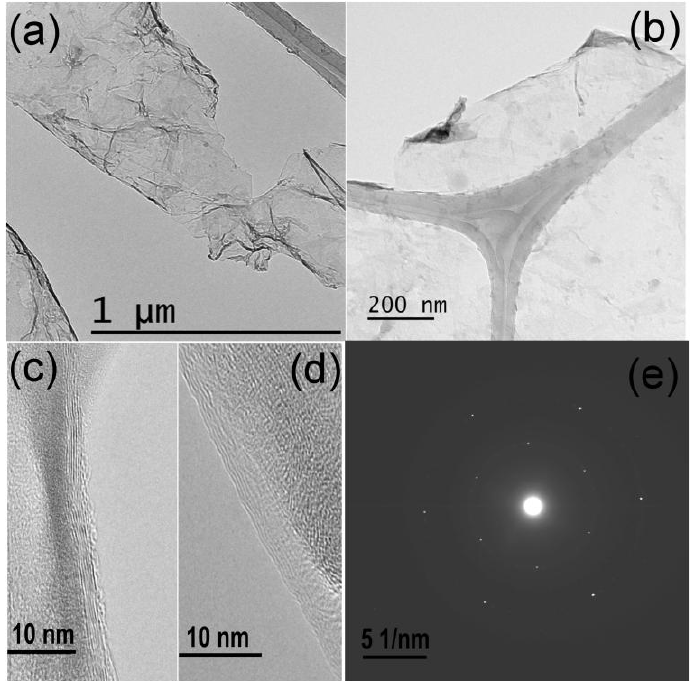
Figure 3. TEM images of large area and continuous graphene films ( a,b ). High-resolution TEM images of the edges of synthesized graphene films ( c,d ). Hexagonal selected area electron diffraction (SAED) pattern of the graphene films ( e ).